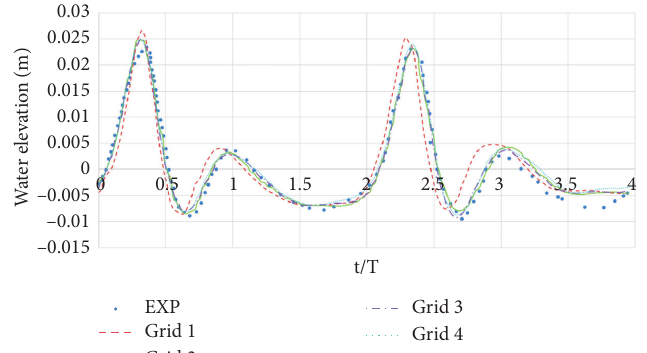
Figure 4: Water surface elevation at x � 14 . 5.